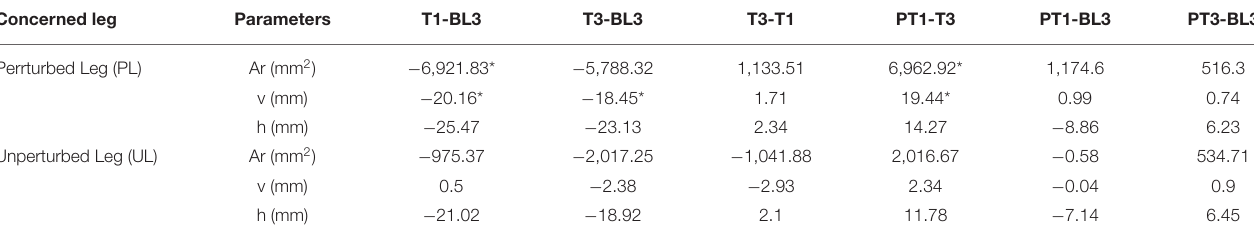
TABLE 2 | Ankle trajectory parameters for both legs, Perturbed Leg (PL) and Unperturbed Leg (UL), in Experiment II.